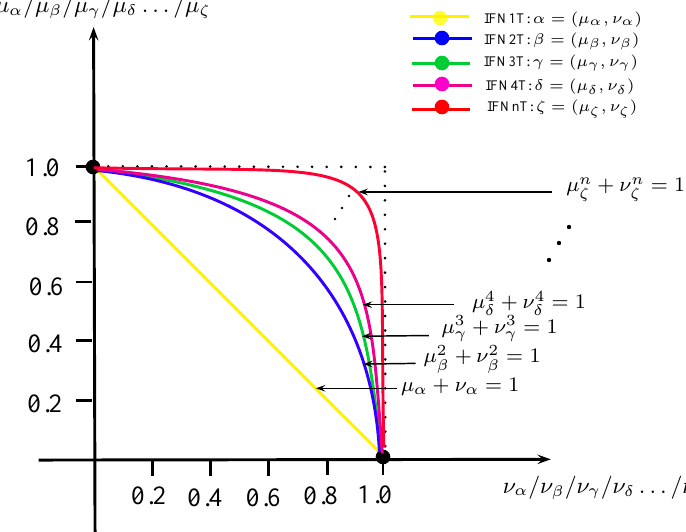
Figure 3.3: Comparison of spaces of IFN1T, IFN2T, IFN3T, IFN4T, · · · , IFNnT. Figure 1. Comparison of spaces of intuitionistic fuzzy sets of n -th type (IFSsnT, given as IFNnT): IFN1T, IFN2T, IFN3T, IFN4T, , · · ·